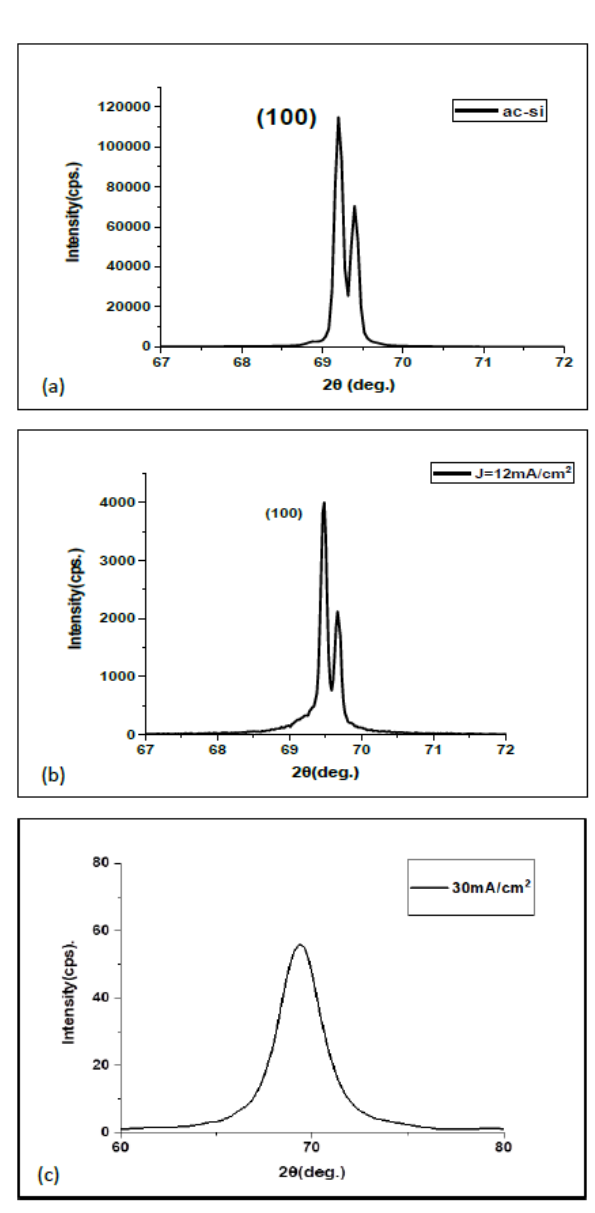
Figure 2: The XRD diffraction patterns of the a) PSi and bulk silicon at various etching current densities of b) 12 c) 30 mA / cm 2 , HFC of 40%, and etching time 10